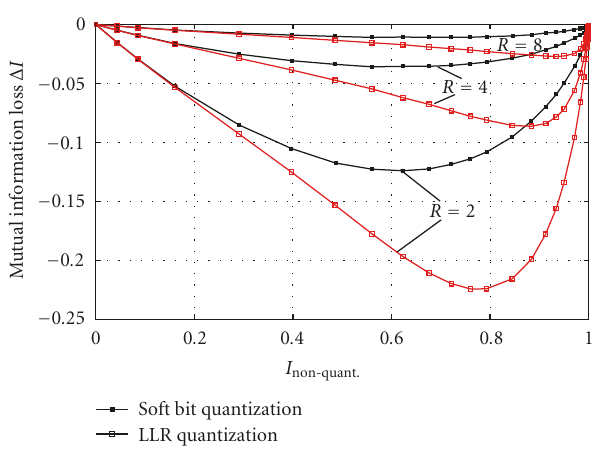
Figure 5: Mutual information loss Δ I ( X ; L ) for nonuniform quantization levels determined in the LLR and soft-bit domains (1– 3 quantization